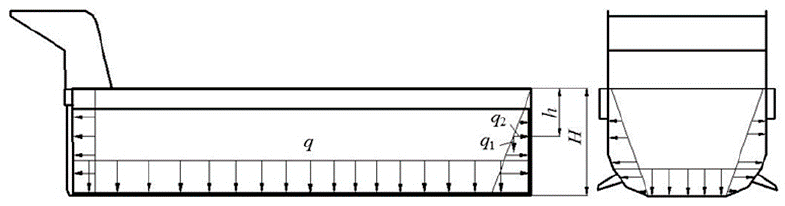
Figure 6. Pressure distribution diagram of each plate of the carriage.